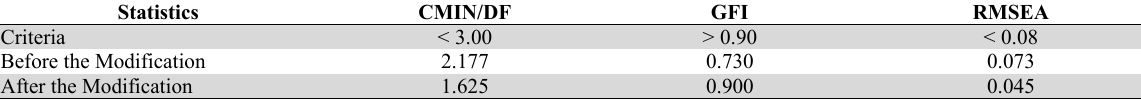
A Statistical Comparison of the Model Before and After the Model Modification Statistics